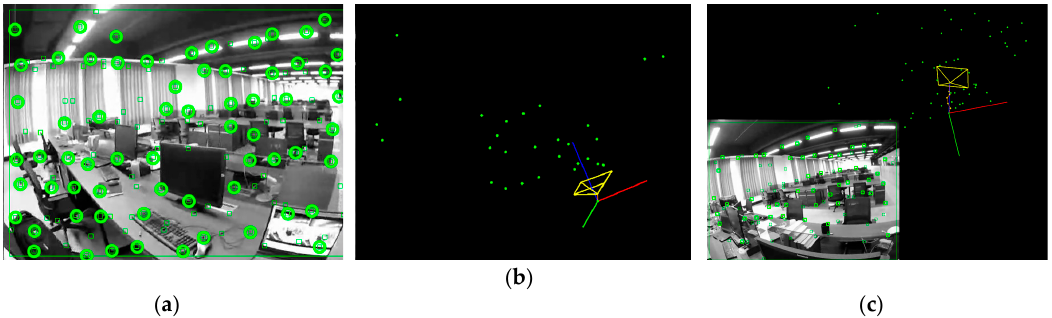
Figure 5. ( a ) Co-vision feature points in the current frame; ( b ) Initial frame pose of the monocular camera; ( c ) Inlier feature points and camera pose tracking.